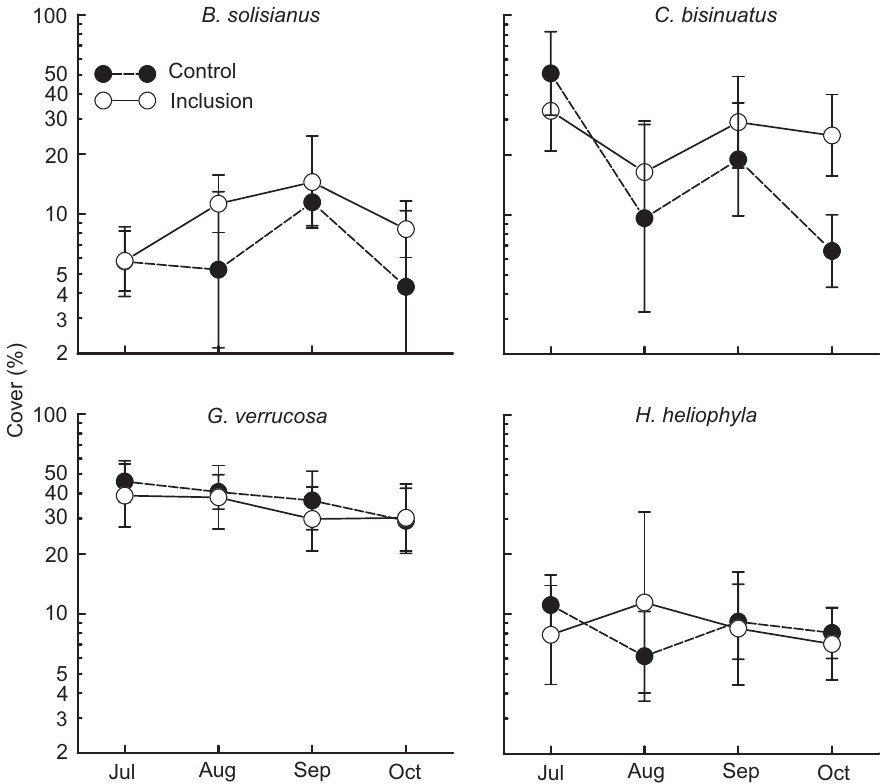
Figure 2. Percent cover (mean ± 95% confidence intervals) of four selected sessile species on permanent quadrats (100 cm 2 ) during an inclusion experiment of A. stellifera in Penha, Santa